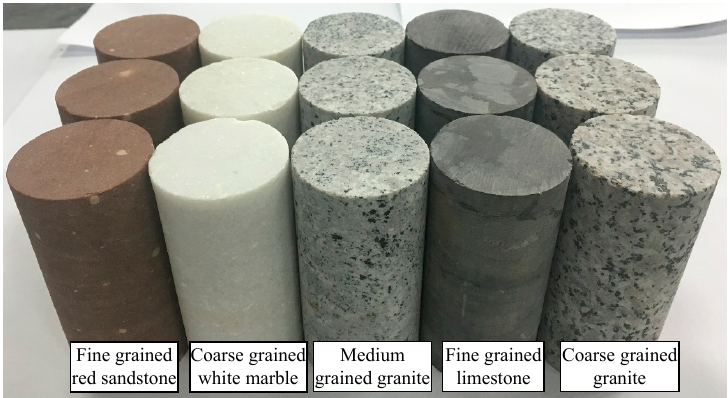
Fine grained Coarse grained red sandstone white marble Figure 1. Intact cylindrical samples with various lithologies. Figure 1. Intact cylindrical samples with various